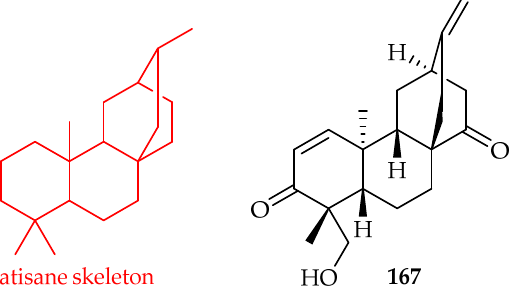
Figure 70. Atisane skeleton and structure of phorneroid H 167 [86].